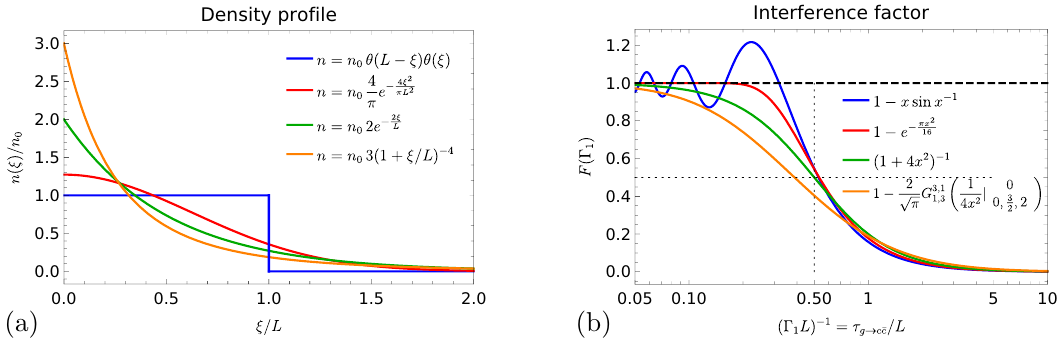
Figure 2 . a) Different density profiles that can be related to the same equivalent static medium of length L and density ¯ n since they satisfy the same line integrals (3.12) and (3.15). b) The inter- 0 ference factors (3.13) for these density profiles interpolate between totally coherent and incoherent limits on a similar scale Γ 2 . G m,n denotes the Meijer 1 L ≈ p,q